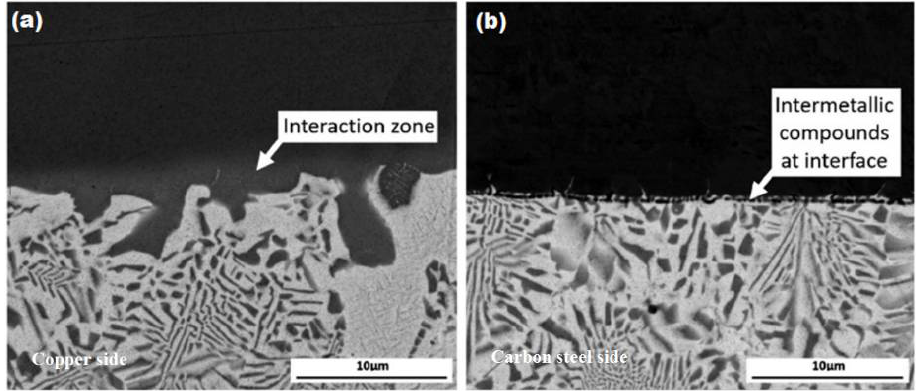
Figure 3. SEM image showing the interface between Ag-155 filler metal and ( a ) copper and ( b ) car- bon steel [14].